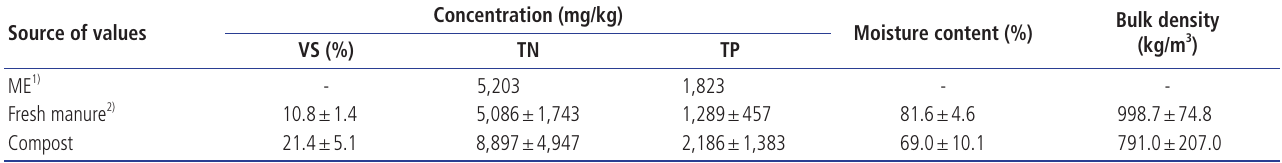
Table 2. Nutrient concentrations of dairy cattle manure and compost according to on farm investigation and the reports from the Ministry of Environment in Korea Source of